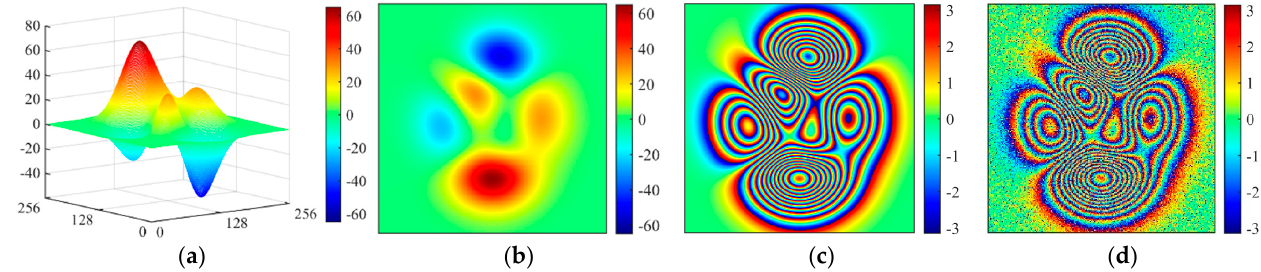
Figure 3. Simulated data for PU accuracy verification (unit is rad): ( a ) three-dimensional display of the simulated terrain phase; ( b ) the simulated unwrapped phase; ( c ) the corresponding wrapped phase; ( d ) the interferogram calculated by adding noise into ( c ). The noise is 0.65